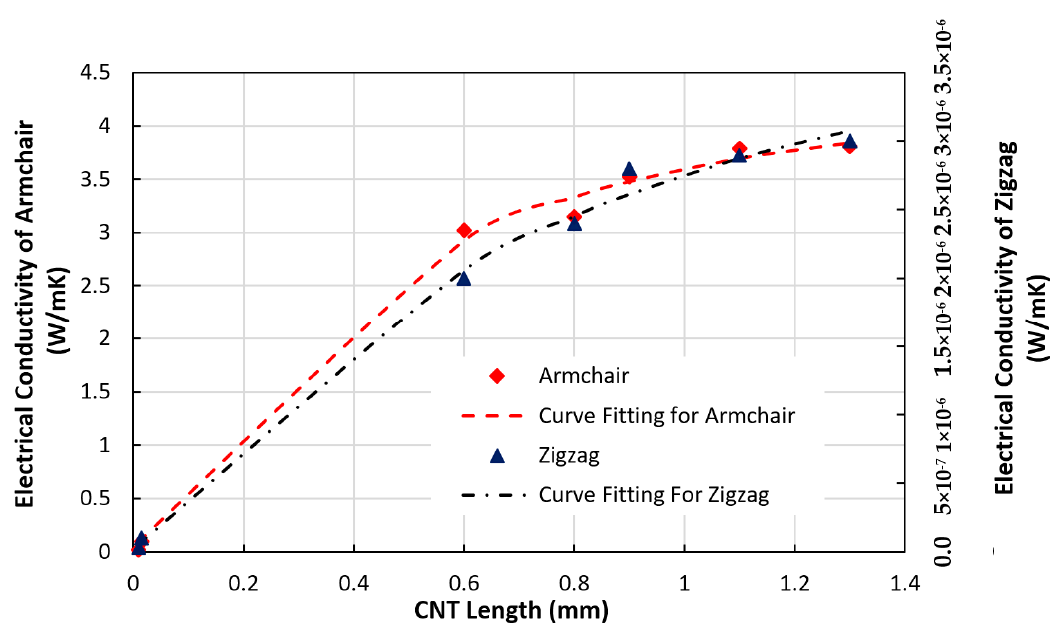
Figure 6. Electrical conductivities of armchair and zigzag SWNTs in a composite vs. CNT length at a CNT volume fraction of 0.0005 and a diameter of 1–2 nm [68,72]. CNT volume fraction of 0.0005 and a diameter of 1–2 nm